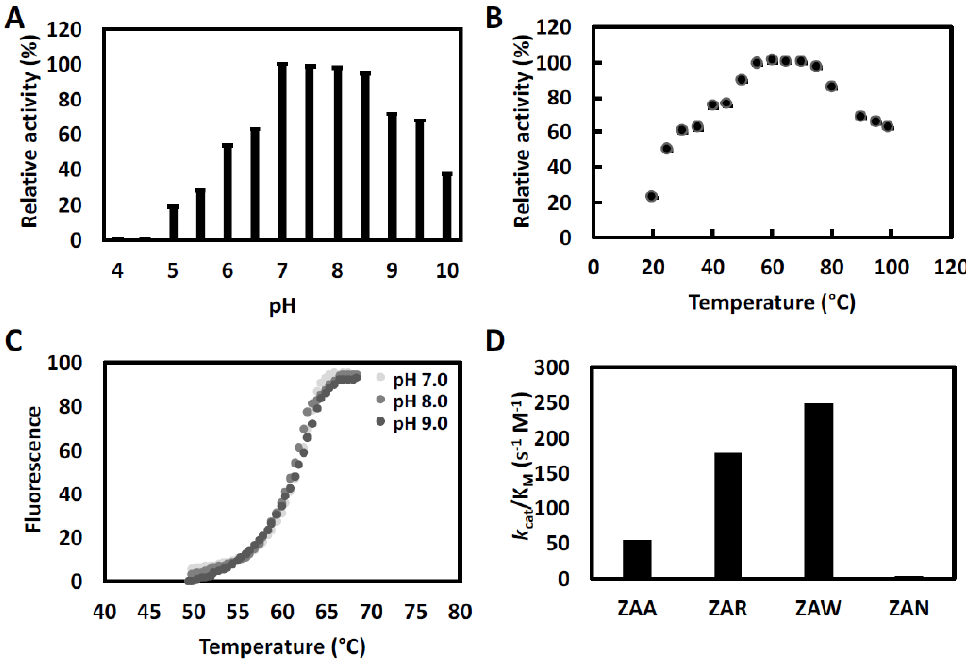
Figure 2. Functional characterization of ChtCP. ( A ): The pH effect on ChtCP activity. Buffers with different pH were tested: sodium citrate (pH 4.0, 4.5, 5.0, 5.5 and 6.0); tris-HCl (pH 7.0, 7.5, 8.0 and 8.5); sodium bicarbonate (pH 9.0, 9.5 and 10.0); ( B ): The temperature effect on ChtCP activity. A total of 1 mg of ChtCP in 100 mM tris-HCl pH 8.0 was incubated for 1 h at different temperatures and the residual activity measured after incubation with 2 mM ZAR. ( C ): melting temperature (Tm) to ChtCP determined via thermal shift assay, where their denaturation promote the release of Sypro orange and the fluorescence (λ excitation = 410 nm, λ emission = 610 nm) released is measured through a ramp of temperature from 40 to 80 °C. The experiment was performed in 50 mM tris-HCl buffer with different pH values (7.0, 8.0 and 9.0). Each condition was performed in triplicate and the data were further normalized. ( D ): Catalytic efficiency ( k cat/K M ) of ChtCP measured against benzyloxycarbonyl Ala-Arg (ZAR), benzyloxycarbonyl Ala-Ala (ZAA), benzyloxycarbonyl Ala-Trp (ZAW) or benzyloxycarbonyl Ala- Asn (ZAN). ChtCP at the concentrations of 0.41 to 1.6 µM were tested against the substrates at the concentration range from 0.195 to 25 mM. The reaction was performed in triplicate with 50 mM hepes and a pH of 8.0 at 65 °C. Table 1. Functional characterization of ChtCP versus substrates with benziloxicarbonil (Z).